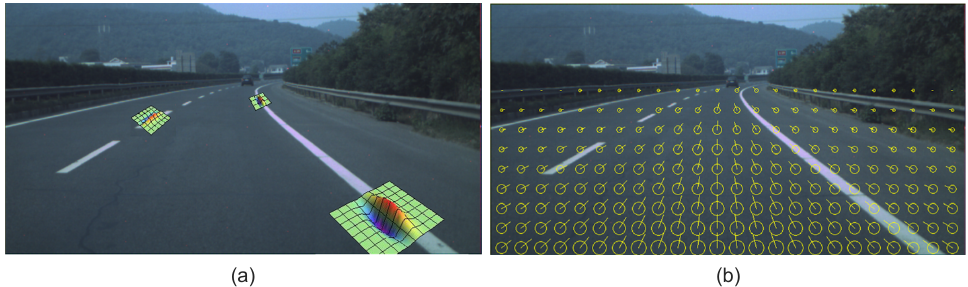
Figure 1. Illustration of the orientation and scale tuning at each location of the input image. ( a ) Ker- nels of different scale and orientation for best detection of the lane markings. ( b ) Scale and orientation assignment according to the prior